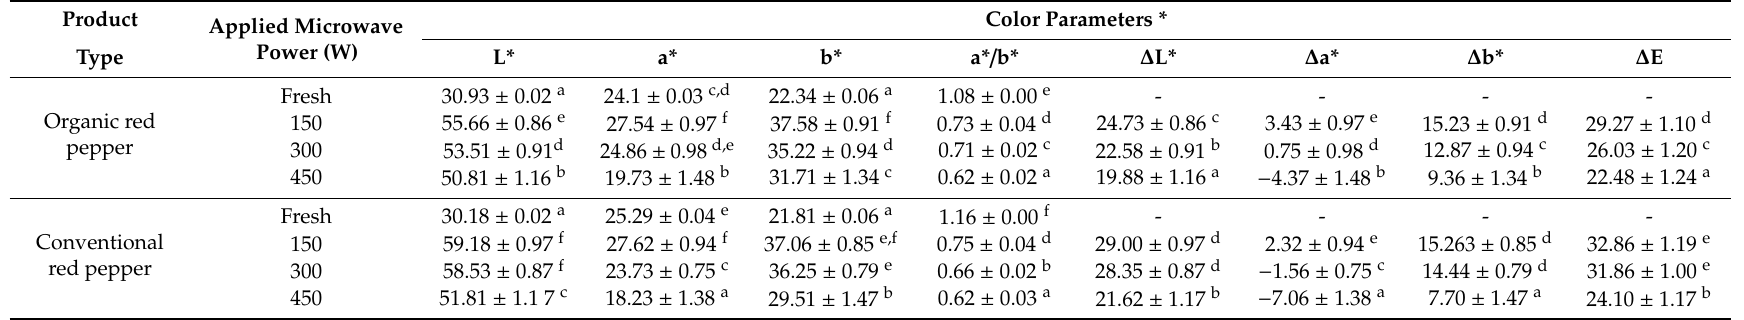
Table 8. Color parameters of fresh and intermittent microwave-dried and powdered organic and conventional red pepper samples ( n = 9; mean ± std.